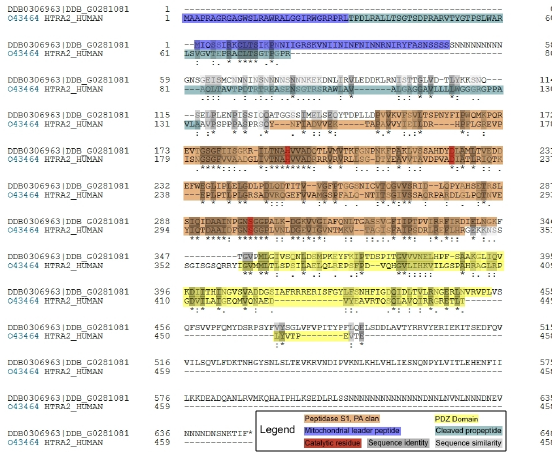
Figure 1. ClustalO sequence alignment of Dictyostelium discoideum and human HTRA2 sequences. The canonical HTRA2 protein in Homo sapiens contains 458 amino acids encoded by a gene 4152 bp long with eight exons and seven introns [33], whereas in D. discoideum , it consists of 647 amino acids encoded by a 2023 bp gene with one intron. The three essential catalytic residues (the catalytic triad) are highlighted in red, including the conserved catalytic serine, substituted with alanine in this and previous work [33]. The alignment was performed using ClustalO [34], the mitochondrial leader peptide was predicted using Mitoprot II [35] and the domains were identified using InterPro Scan [36]. The human protein includes a propeptide that is removed during processing to form the mature protein [37]. The Dictyostelium protein includes additional low complexity regions near the N- and C-termini. Such low complexity “additions” are common in Dictyostelium